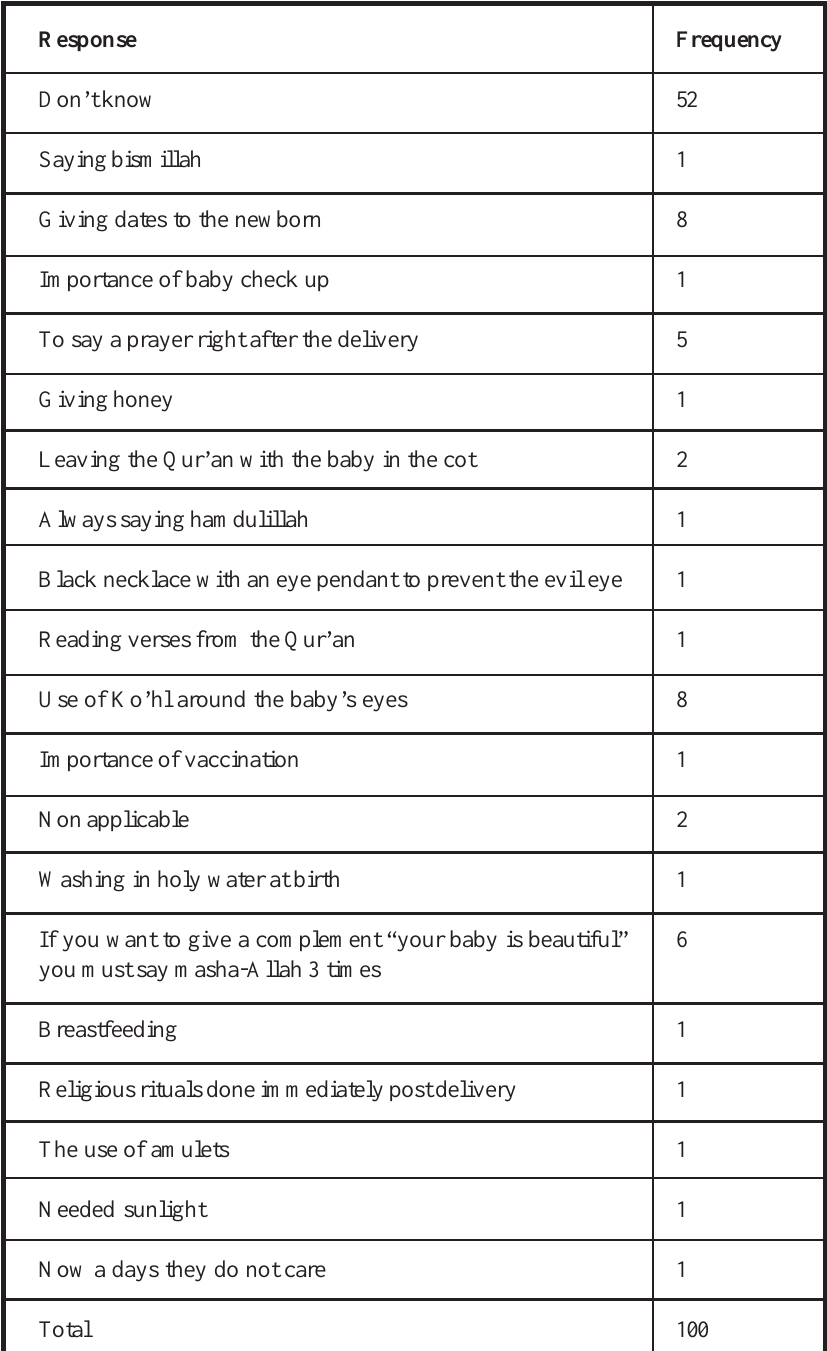
Table 1: Practices associated with the prevention of ill health to the baby